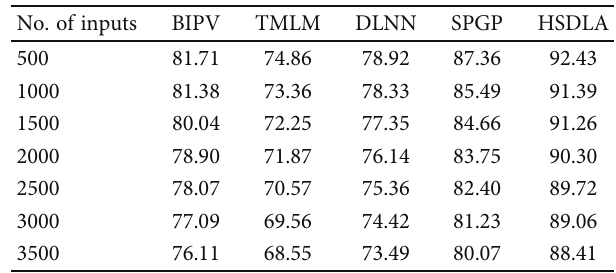
Table 1: Flat-blade collector management. Table 2: Integrated collector-storage systems management.